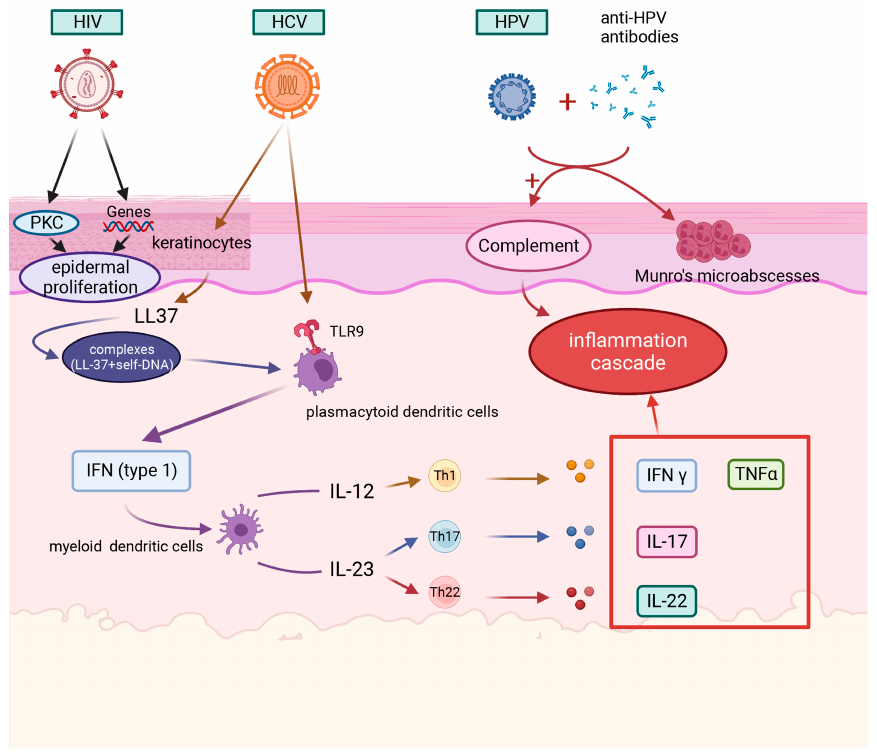
Figure 2. Roles of viruses (HIV, HCV, and HPV) in psoriasis. HIV: The tat gene promotes HIV replication, leading to cell proliferation through PKC-dependent or -independent pathways. HCV: HCV upregulates cathelicidin, TLR9, and IFN- γ to promote inflammation. HPV: The interaction of anti-HPV antibodies with viral proteins causes complement activation and Munro’s microabscesses. Created with BioRender.com on 21 June 2022.